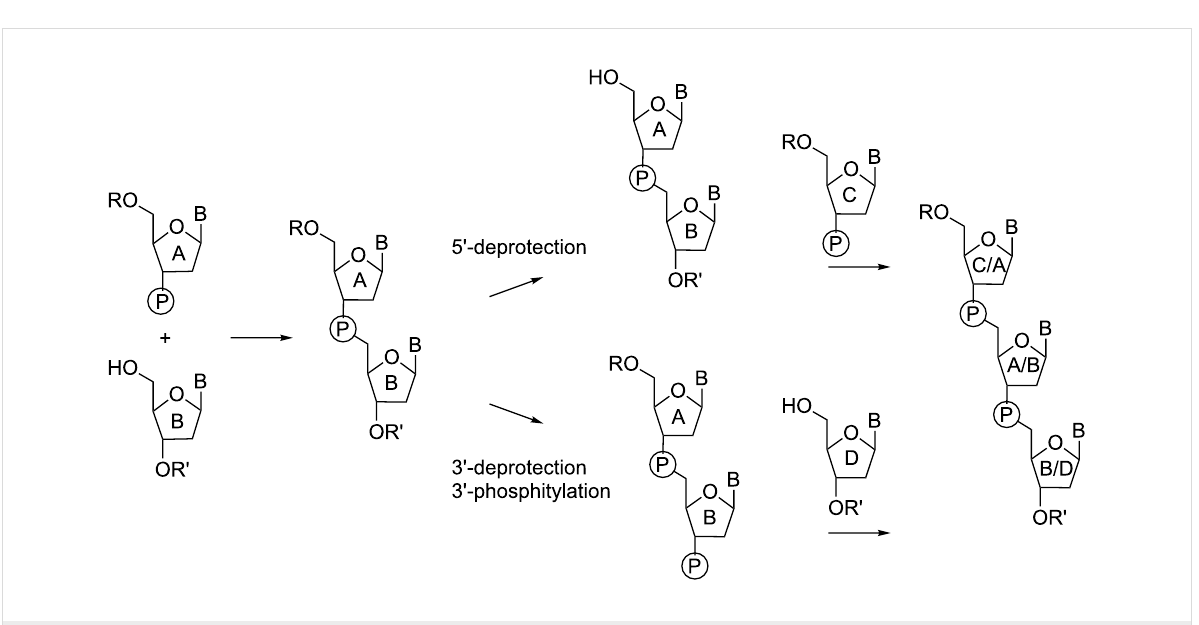
Figure 3: Strategy for the synthesis of nucleotide dimers and extension to the trimer in either 5'- or 3'-direction.